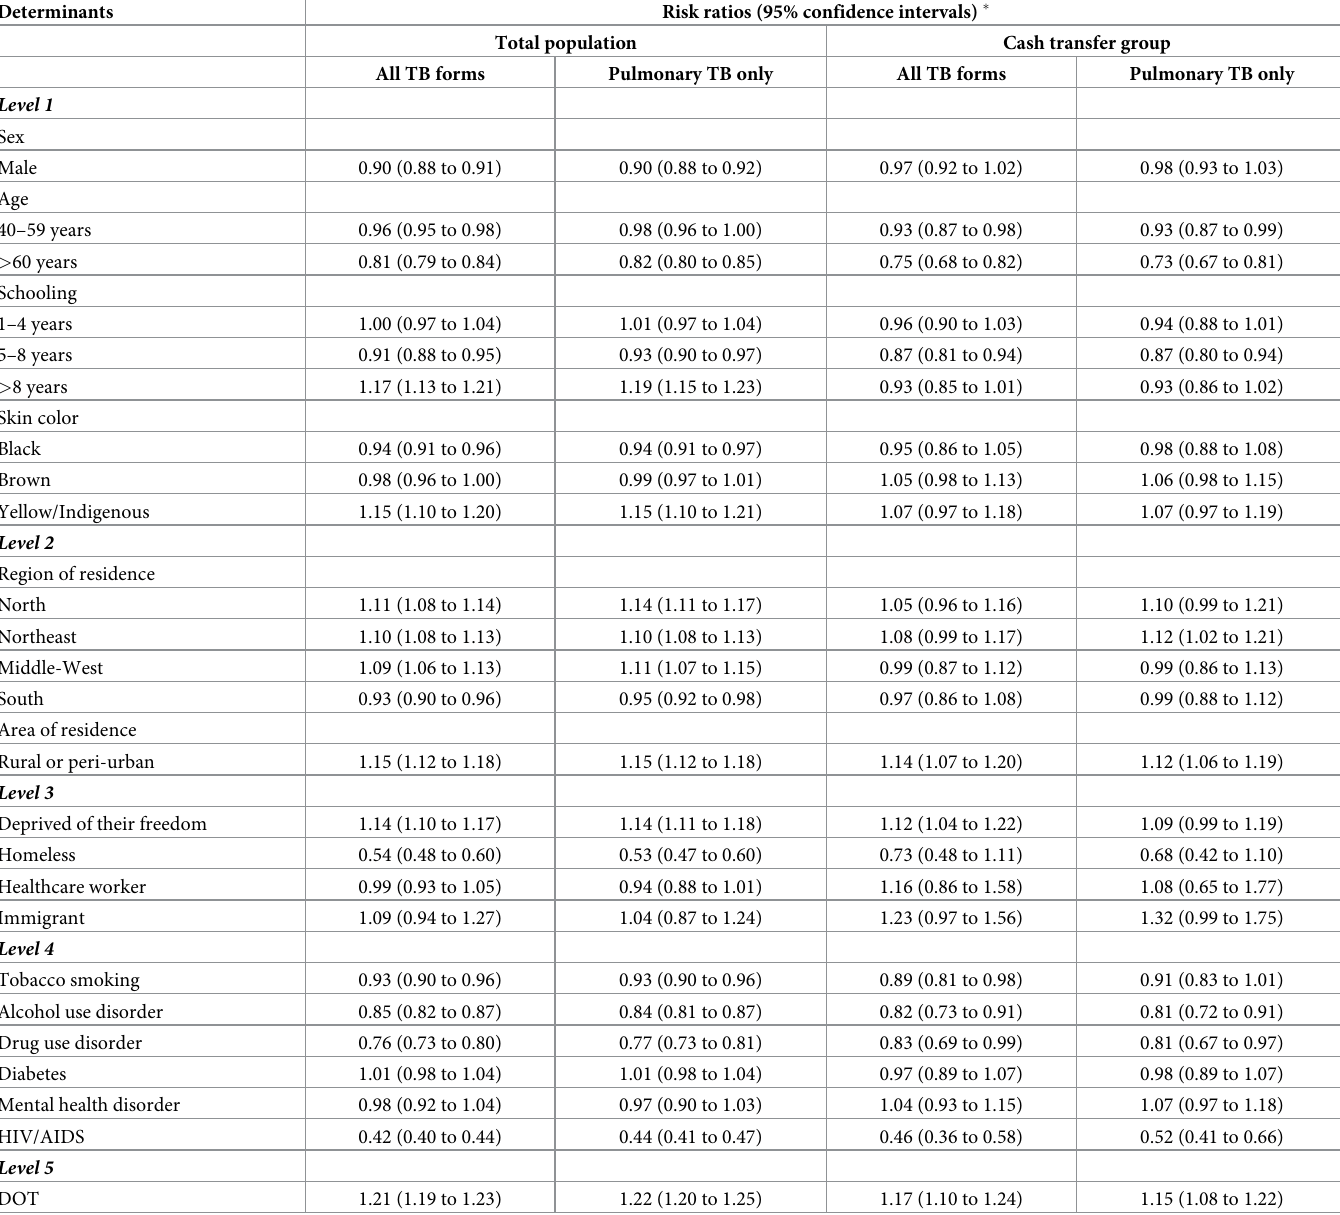
Table 3. Adjusted � risk ratios of hierarchical Poisson regression models of the association of determinants of TB and treatment cure rates to 25,084 people from the Brazilian Notifiable Disease Information System database (SINAN),